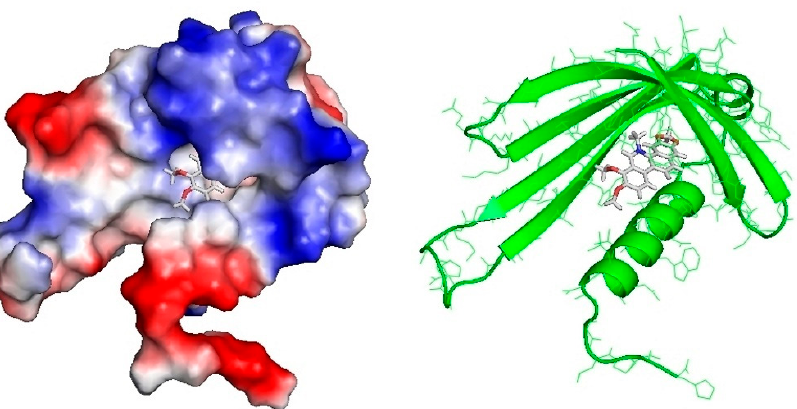
Figure 6. Left: 3D model of C. majus MLP with surface representation, colored according to the distribution of the electrostatic surface potential calculated with ABPS (PyMol). Positively charged regions in blue and negatively charged regions in red. Hydrophobic cavity filled by dihydroberberine (docking affinity 5.98). Right: MLP in a ribbon representation with docked 8-hydroxycheleritrine (docking affinity 5.94).